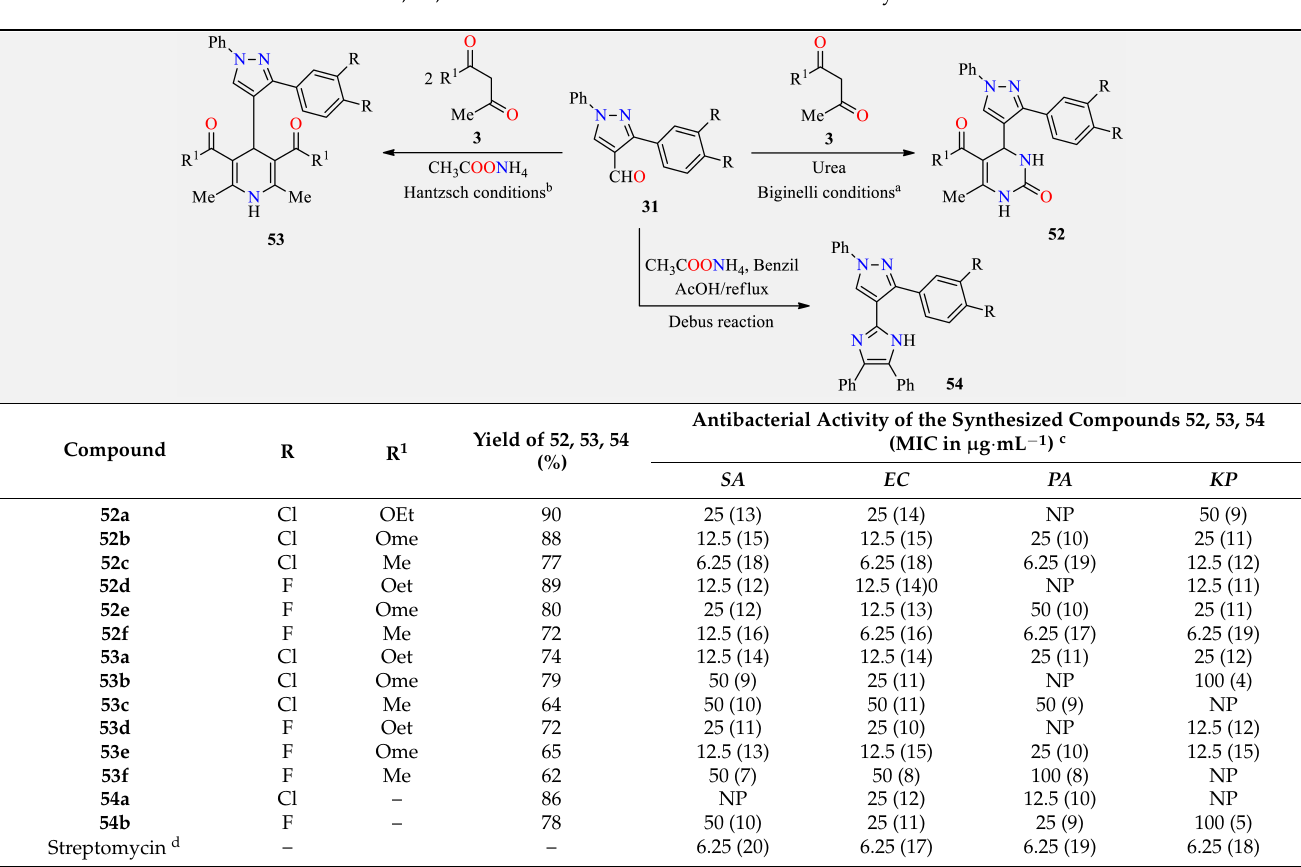
Table 14. Multicomponent synthesis of pyrimidine-, dihydropyridine-, and imidazole-based pyra- zoles 52 , 53 , and 54 and their in vitro antibacterial